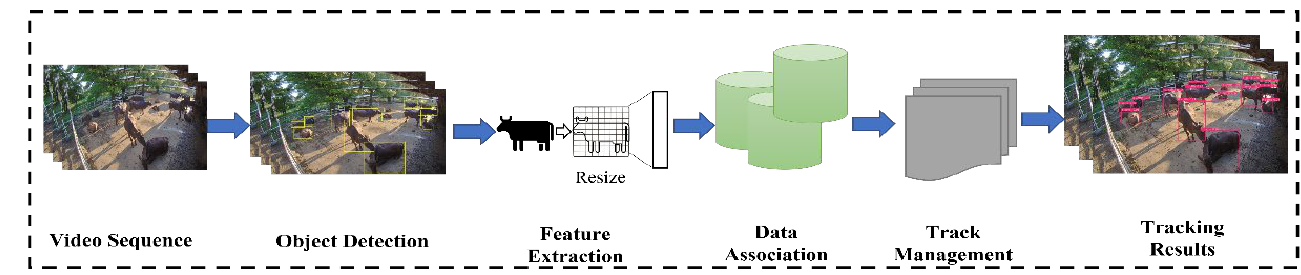
Figure 5. Cattle Tracking with Strong-SORT.